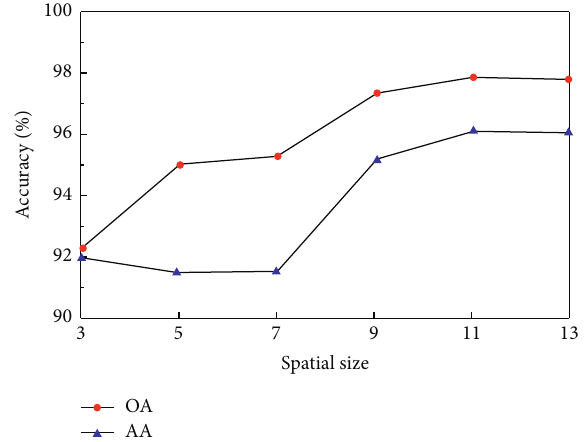
Figure 6: The influence of space size on classification accuracy. spatial size as the optimal parameters. The weight of the Mixup method is set to 0.5. All results are the average of 10 repeated experiments. The comparison of classification re- sults of different methods is shown in Table 4.